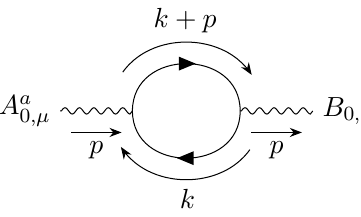
Figure 4. The diagram contributing to the B ∧ F